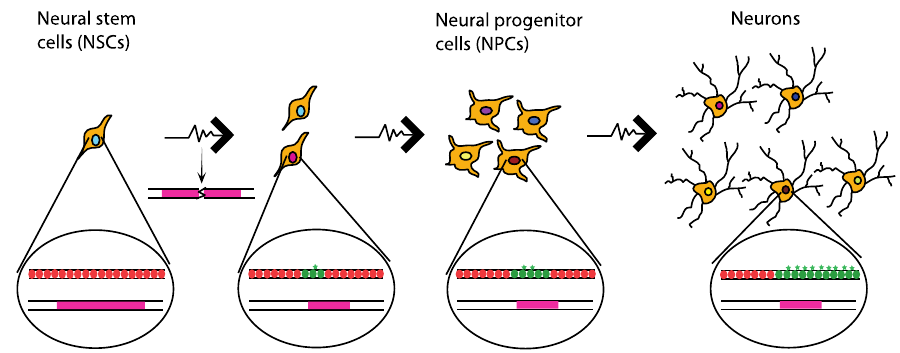
Figure 3. Hypothetical model showing diversification of neurons as a result of replication stress at CFSs. As neural stem cells (NSCs) proliferate, replication stress (spiked arrow) can result in loss of coordination of the histone deposition and replication process. As a consequence, histones that carry modifications (red circles) are replaced by newly synthesized unmodified histones (green circles). Replication stress at CFSs also causes accumulation of the histone variant macroH2A1.2 (green star). At the genetic level structural variations, like deletions, can arise due to replication stress-induced breaks. The variance at the genetic and the epigenetic level that is caused by replication stress throughout the differentiation of neurons can lead to variance of the expression of the genes located at CFSs. Each individual cell will then have a different expression profile (as indicated by the different colours of cell nuclei), which will eventually lead to a diverse population of neurons that is necessary to perform the complex functions of the brain.